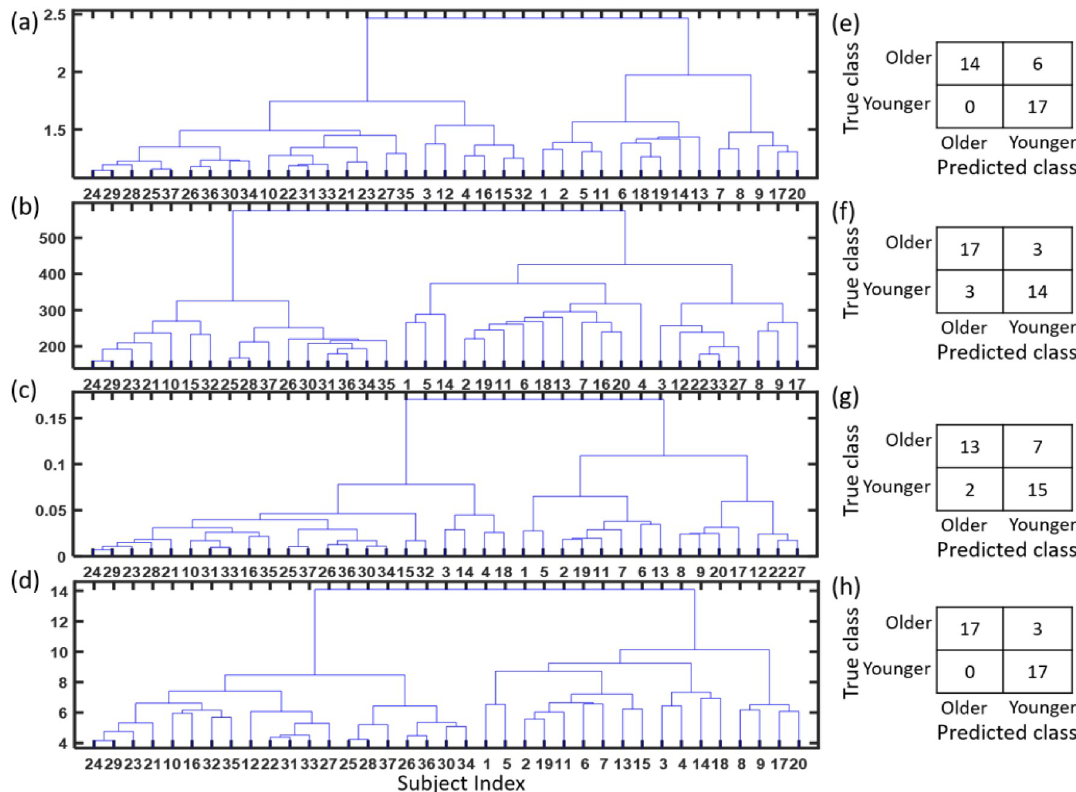
Fig 6. Clustering of brain connectivity matrices from pilot data set of young vs. old healthy persons. A-dendrogram based on RS, B-dendrogram based on T-statistics, C-dendrogram based on S-statistics, D-dendrogram based on snake vectors, E-H- confusion matrices for the above four approaches. Note that in all four approaches we used a hierarchical clustering method to allow direct comparison.